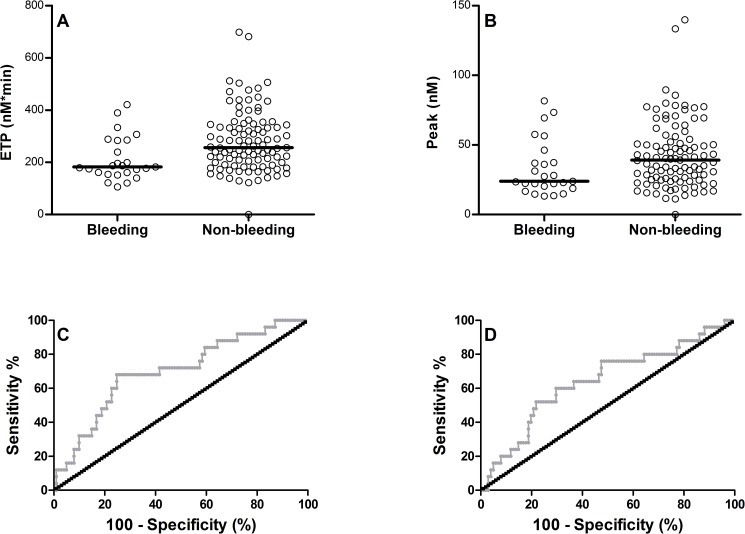
Whole blood CAT analysis of patients with and without bleeding symptoms.(A) Difference in whole blood endogenous thrombin potential (ETP) (p = 0.002) in patients with and without bleeding. (B) Difference in whole blood peak (p = 0.029) in patients with and without bleeding. (C) Receiver operating curve (ROC) of the ETP in whole blood thrombin generation (area under the curve (AUC) = 0.700, p = 0.002). (D) Receiver operating curve (ROC) of the peak in whole blood thrombin generation (AUC = 0.642, p = 0.029).